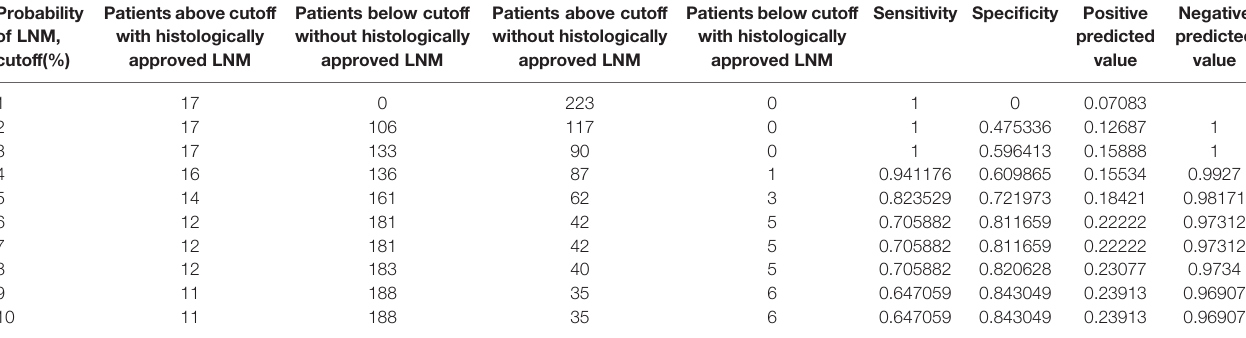
TABLE 3 | Systematic analyses of the nomogram-derived cutoffs used to discriminate between patients with or without histologically con fi rmed lymph node metastasis. Probability Patients above cutoff Patients below cutoff of LNM, with histologically without histologically approved LNM approved cutoff(%)